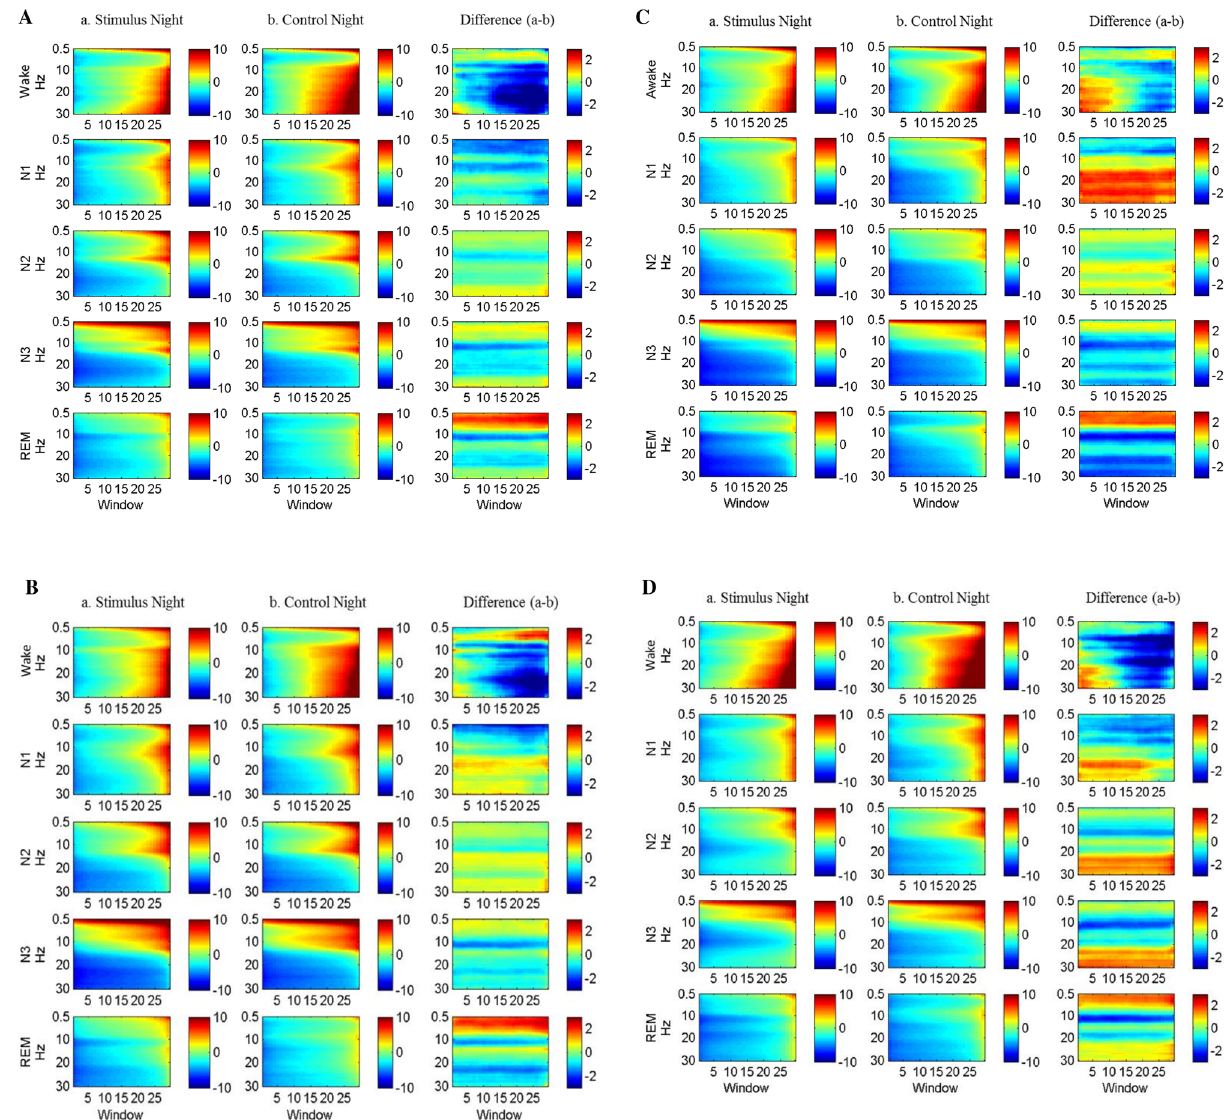
Figure 4. EEG spectrum during the release of lavender oil. ( A ) Cz channel, ( B ) Fz channel, ( C ) Oz channel, ( D ) T3 channel, ( E ) T4